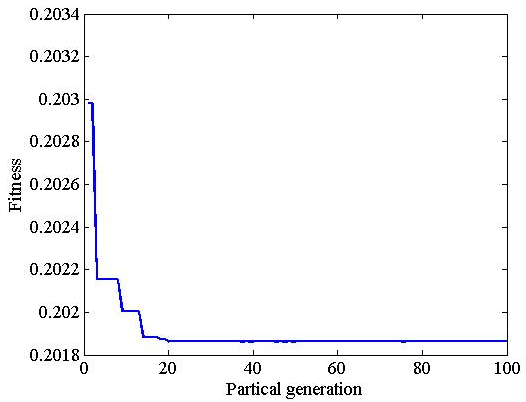
Figure 7. Profile of fitness with respect to particle generation.